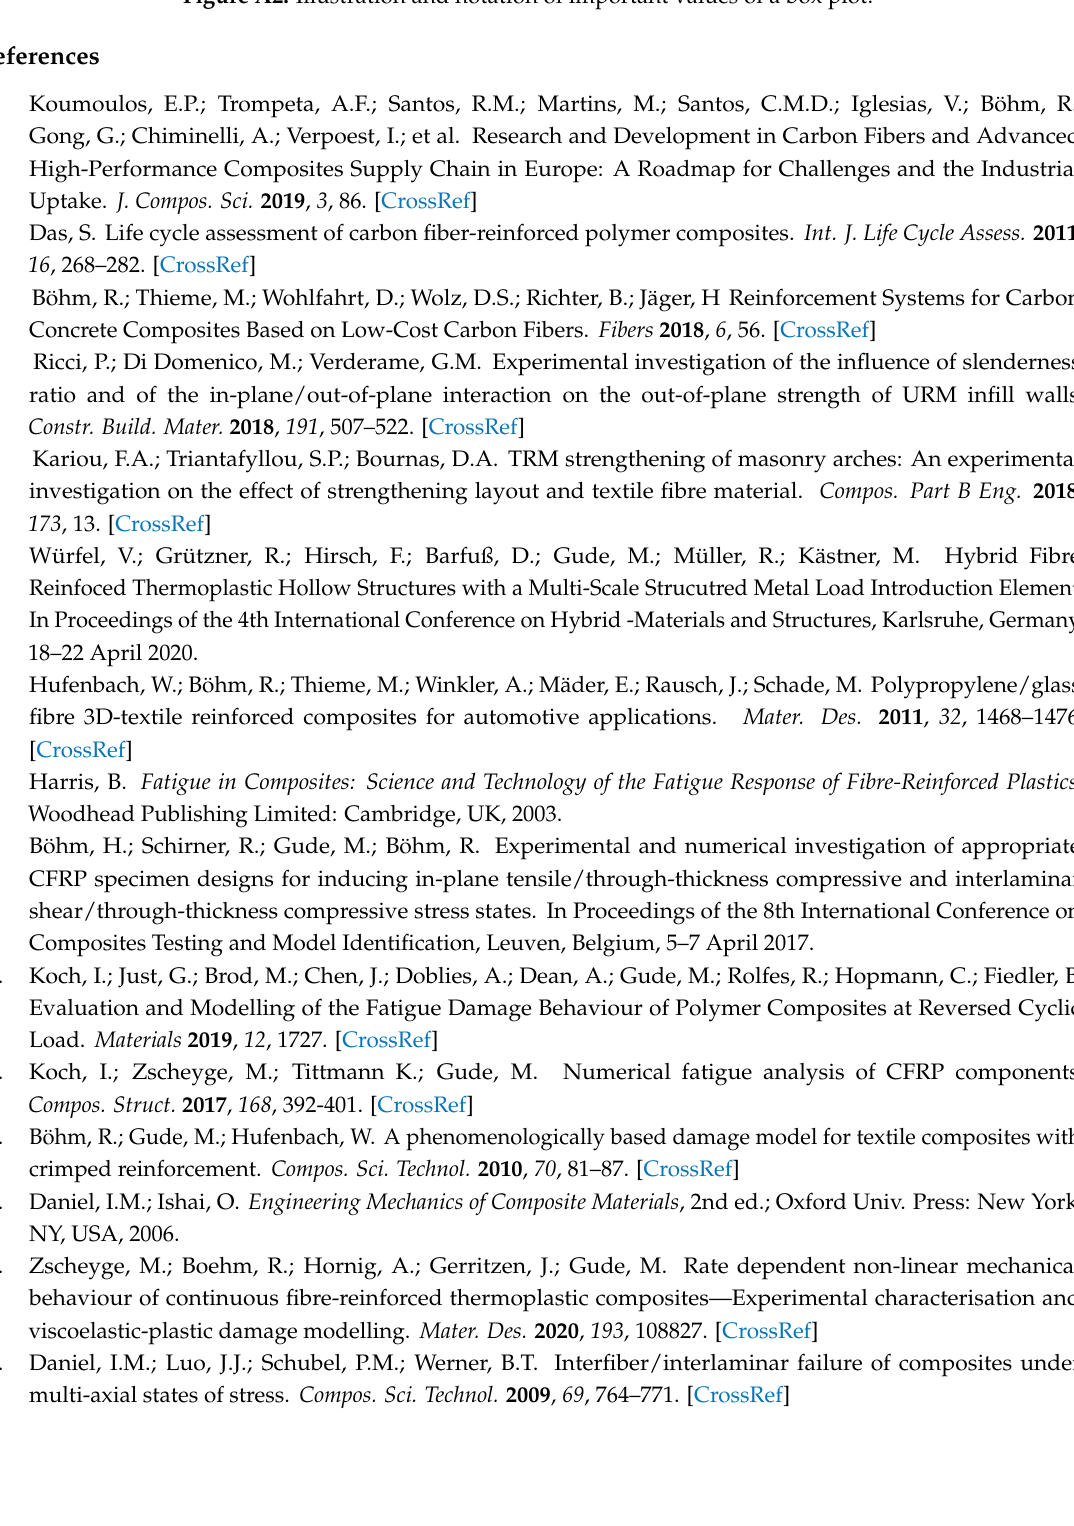
Figure A2. Illustration and notation of important values of a box